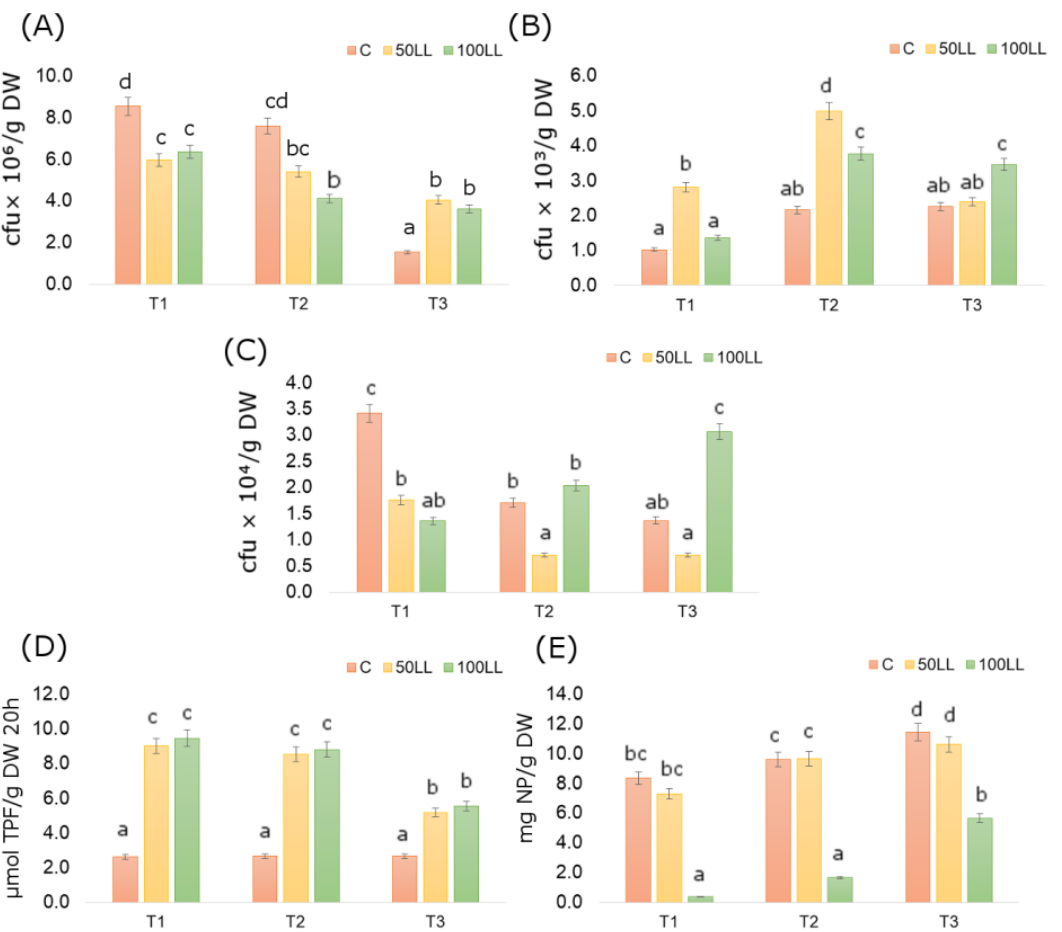
Figure 2. Abundance of soil total bacteria ( A ), fungi ( B ), fluorescent bacteria Pseudomonas sp. ( C ), and enzymatic activity of Dha ( D ) and β -Glu ( E ) in samples from C (control), 50LL (50% of dose N), and 100LL (100% of dose N) collected at T1, T2 and T3; the same letters mean non-significant differences between treatments assessed by Tukey post-hoc test at p < 0.05.